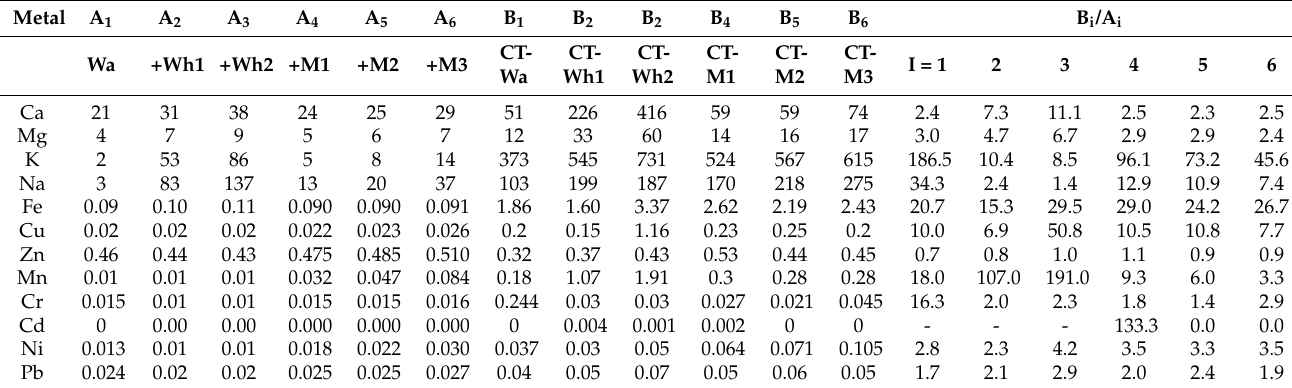
Table 5. Enrichment factors (B i /A i ratio ) of the final CTs referred to the metal content of tap water and the used additives (molasses and